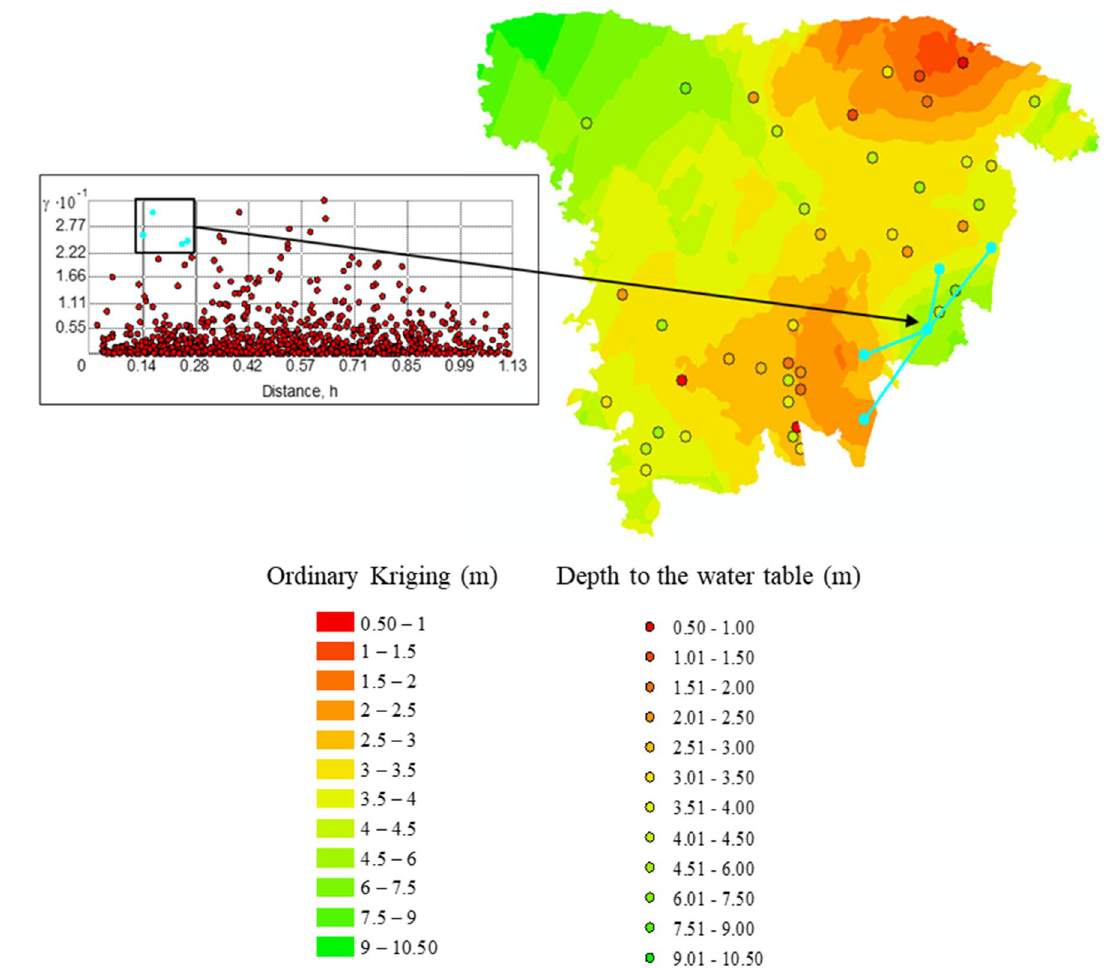
Fig. 2 Semivariogram plot for the depth to water table for